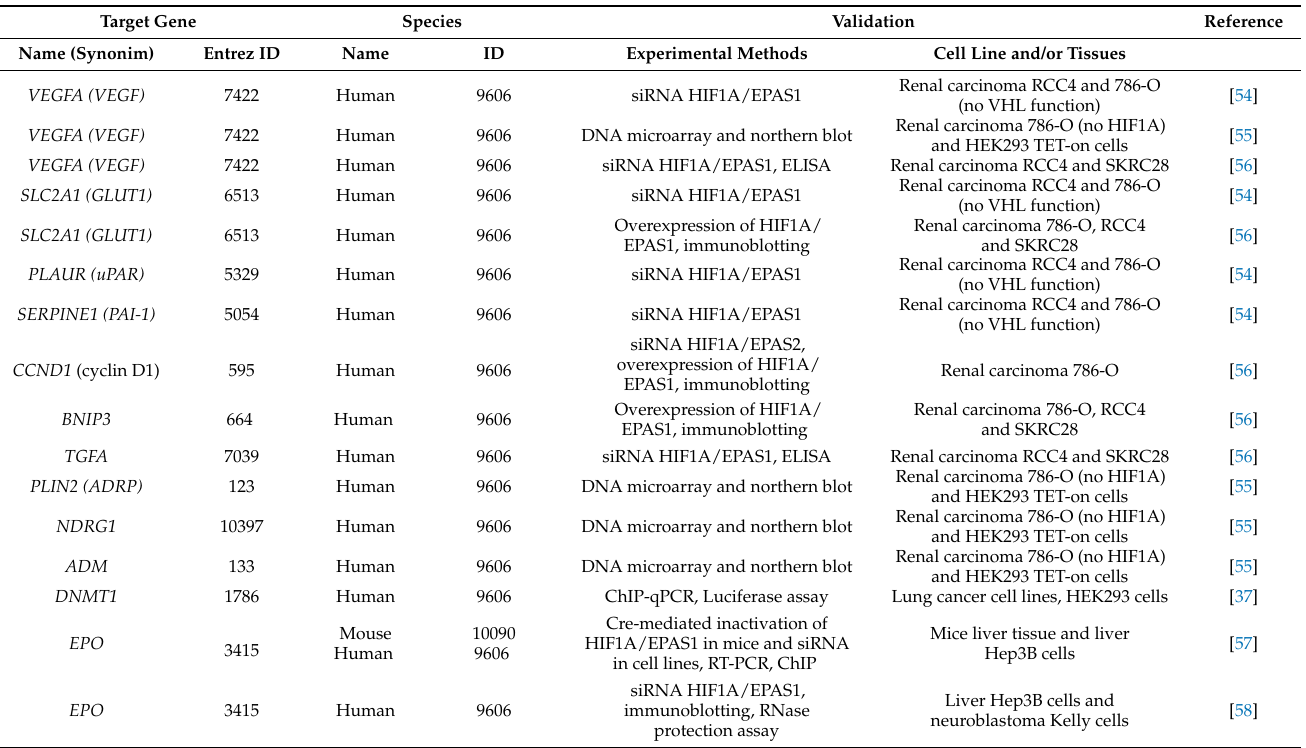
Table 3. Obtained downstream targets of the EPAS1 from the